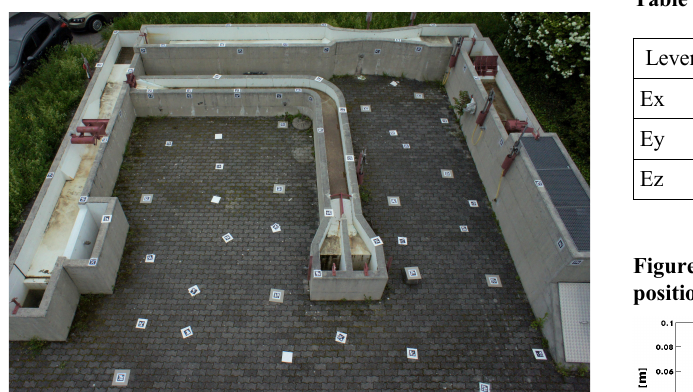
Figure 4 . Calibration field